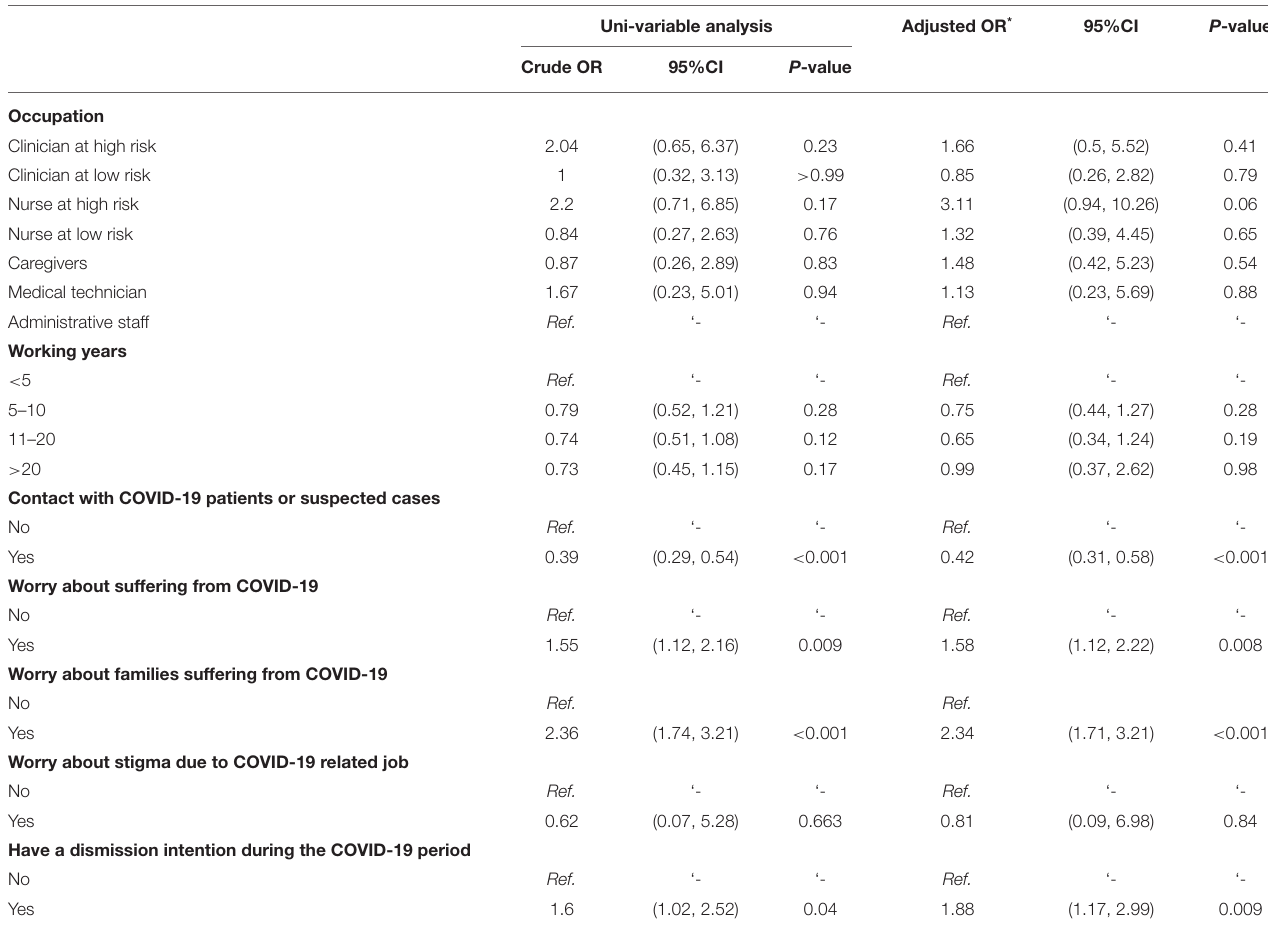
TABLE 3 | Factors associated with anxiety during the COVID-19 period for healthcare workers ( N = 908) in Guangdong,